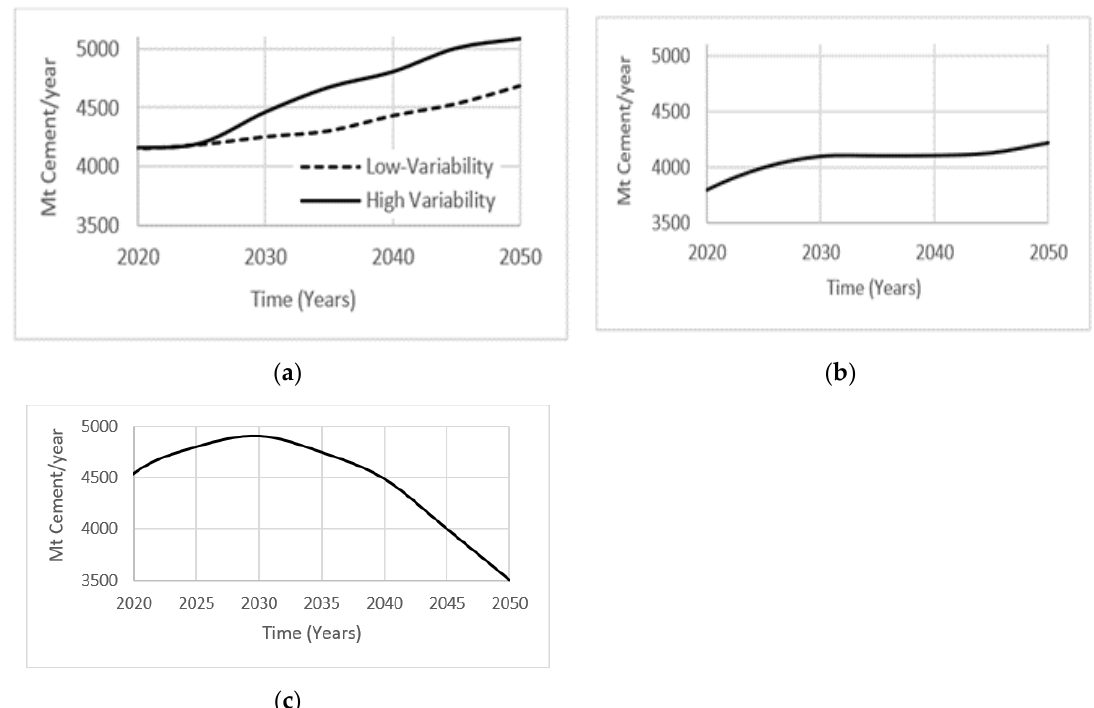
Figure 4. Projected cement projection based on ( a ) International Energy Agency (IEA); ( b ) carbon tax increase; and ( c ) closing GDP.